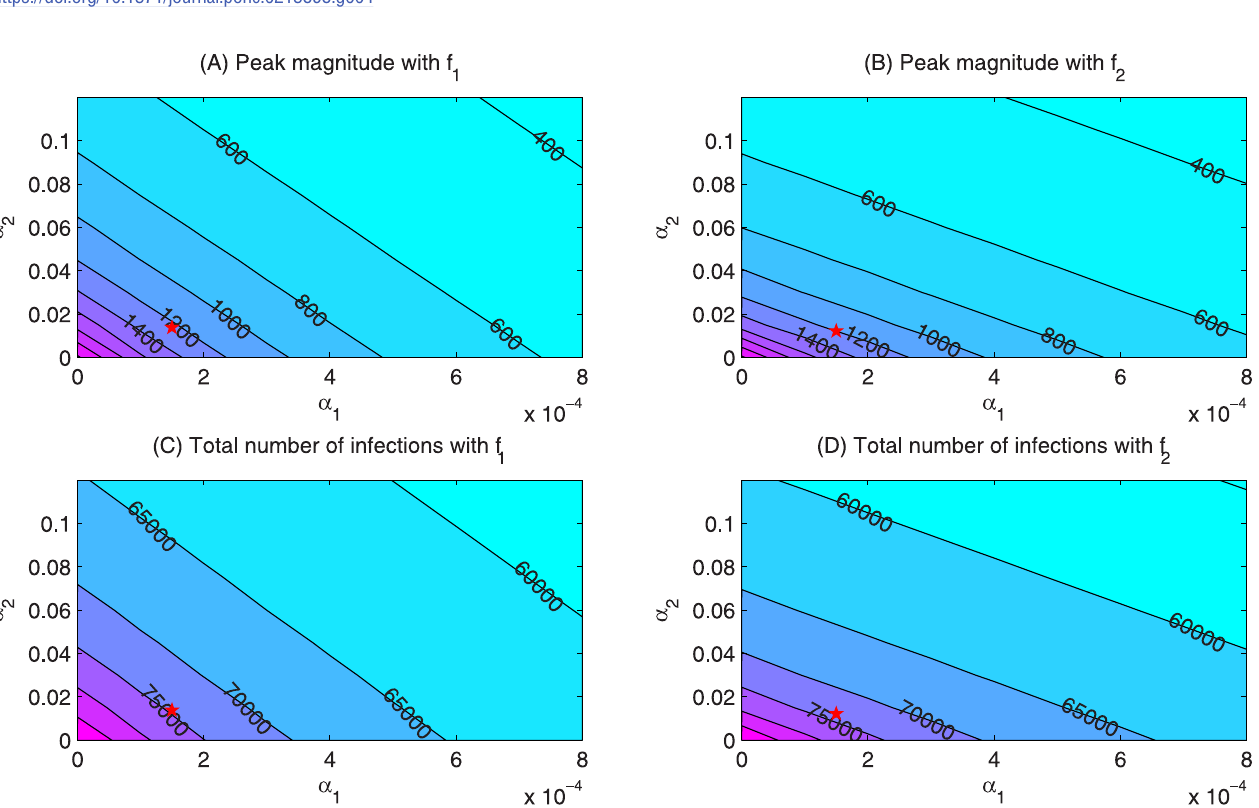
Fig 5. Contour plots. Contour plots of the peak magnitude and the total number of infections versus α 1 and α 2 by using media functions f 1 and f 2 , respectively. The red star represents the α 1 and α 2 we have parameterized by using the real data.